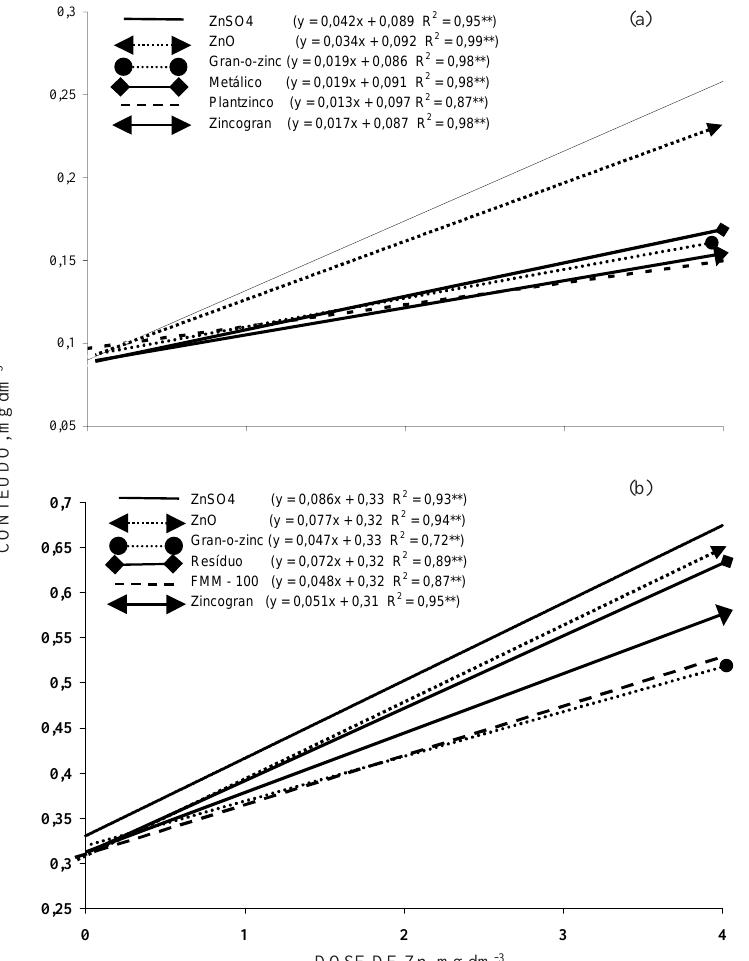
Figura 1. Efeito das fontes e doses de Zn no conteúdo do elemento em plantas de arroz (a) e de milho